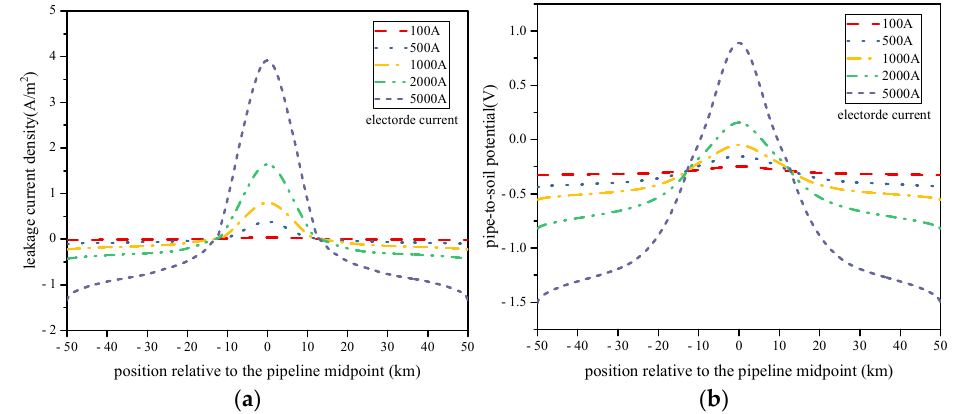
Figure 10. Calculation results under different HVDC grounding currents. ( a ) leakage current density along the pipeline; ( b ) PSP along the pipeline.